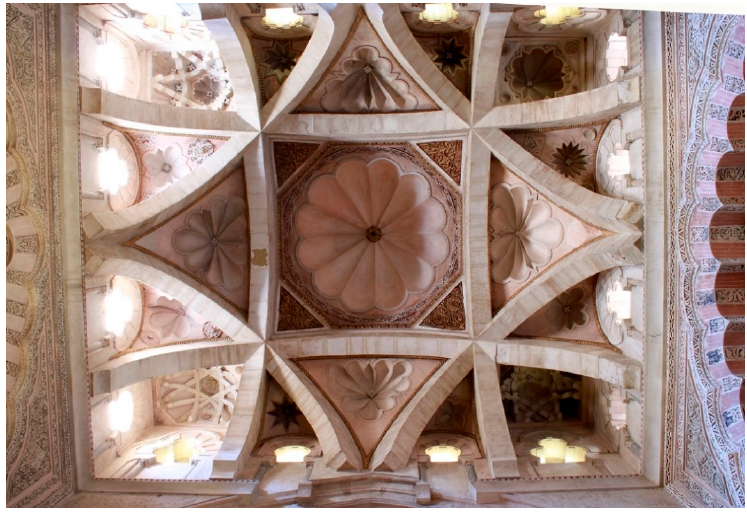
Figure 5. Great Mosque of Cordoba. Ribbed dome at the northern end of the axial nave in the caliphal enlargement (10th century). © Photo took by